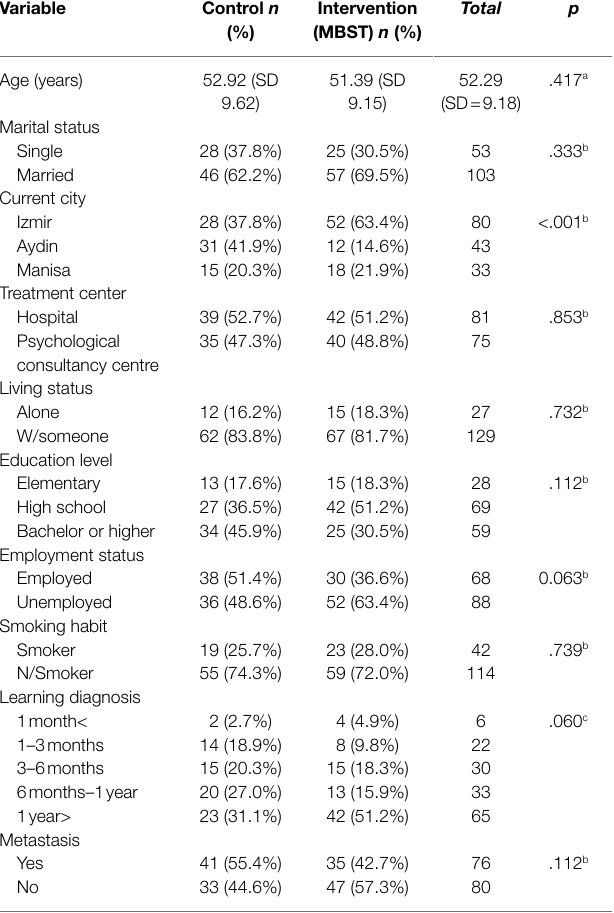
TABLE 1 | Demographic data of the two study groups. TABLE 2 | Frequency for hope and comparing the control and intervention